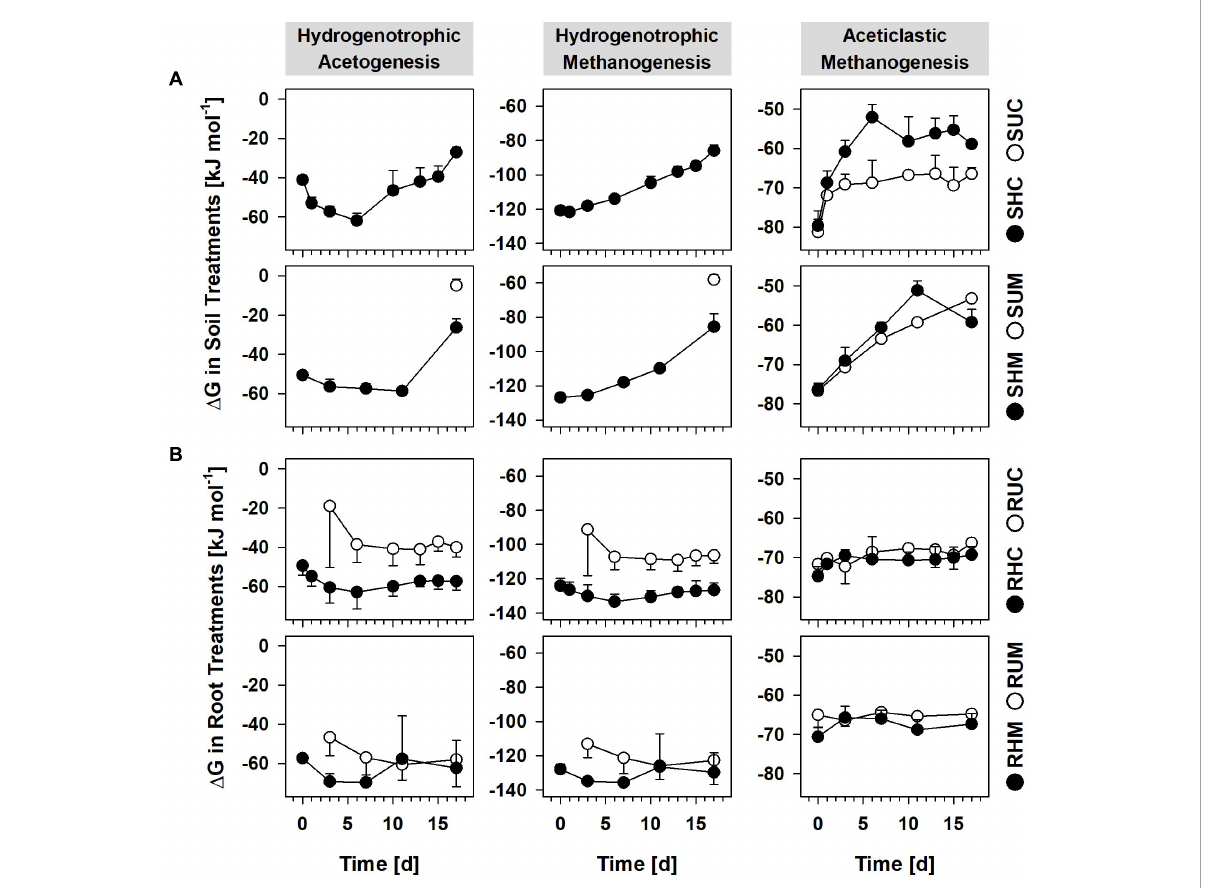
FIGURE4 Gibbs free energies ( (cid:49) G) of anaerobic processes in soil treatments (A) and root treatments (B) . (cid:49) Gs were calculated based on the following reactions: hydrogenotrophic acetogenesis, 4H 2 + 2CO 2 → CH 3 COO − + H + + 2H 2 O; hydrogenotrophic methanogenesis, 4H 2 + CO 2 → CH 4 + 2H 2 O; aceticlastic methanogenesis, CH 3 COO − + H + → CH 4 + CO 2 . • , H 2 treatments; ◦ , unsupplemented treatments; when H 2 was below the detection limit ( ∼ 10 ppmV) no (cid:49) Gs could be calculated for hydrogenotrophic acetogenesis and hydrogenotrophic methanogenesis. Values represent means of triplicate analysis and error bars indicate standard deviations. Treatments: SHC, H 2 supplemented Carex soil; SUC, unsupplemented Carex soil; SHM, H 2 supplemented Molinia soil; SUM, unsupplemented Molinia soil; RHC, H 2 supplemented Carex roots; RUC, unsupplemented Carex roots; RHM, H 2 supplemented Molinia roots; and RUM, unsupplemented Molinia